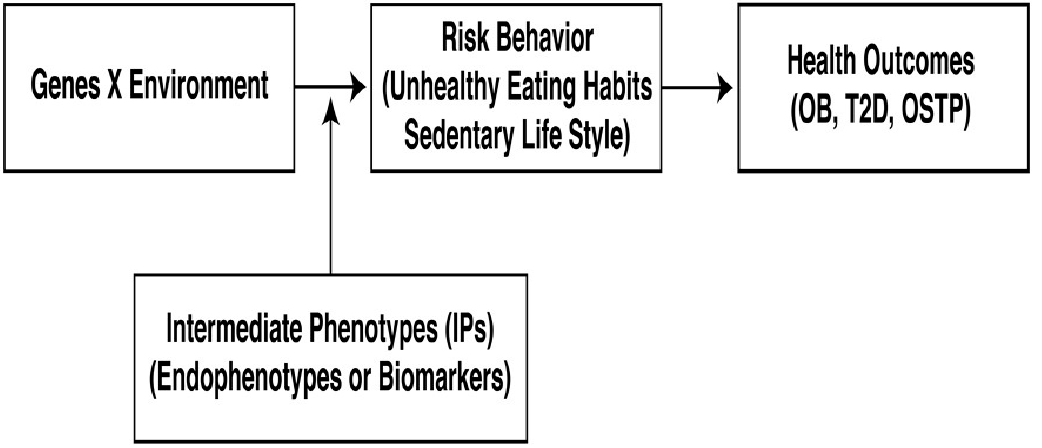
Figure 1. Basic predictive model showing how IPs (endophenotypes, biomarkers) link gene-environment effects on risk behaviors (unhealthy eating habits and sedentary life styles) to detrimental health outcomes (obesity, diabetes, osteoporosis) .